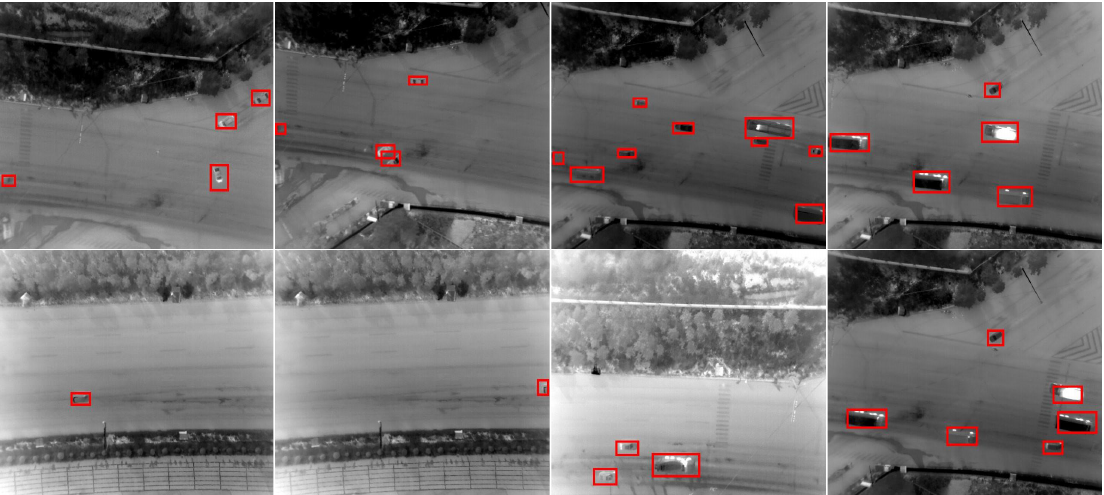
Figure 8. The performances of the method on part images of NPU_DJM100_2